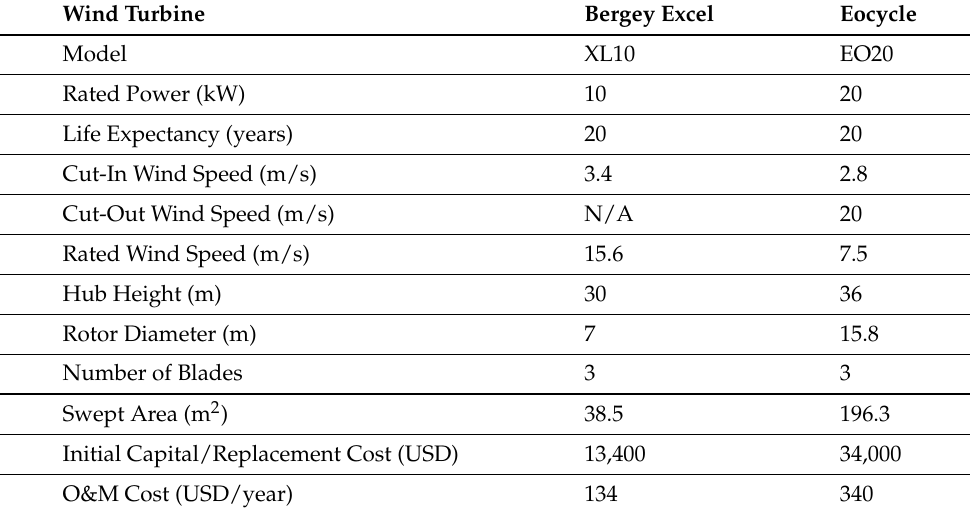
Table 6. Wind turbine technical data and